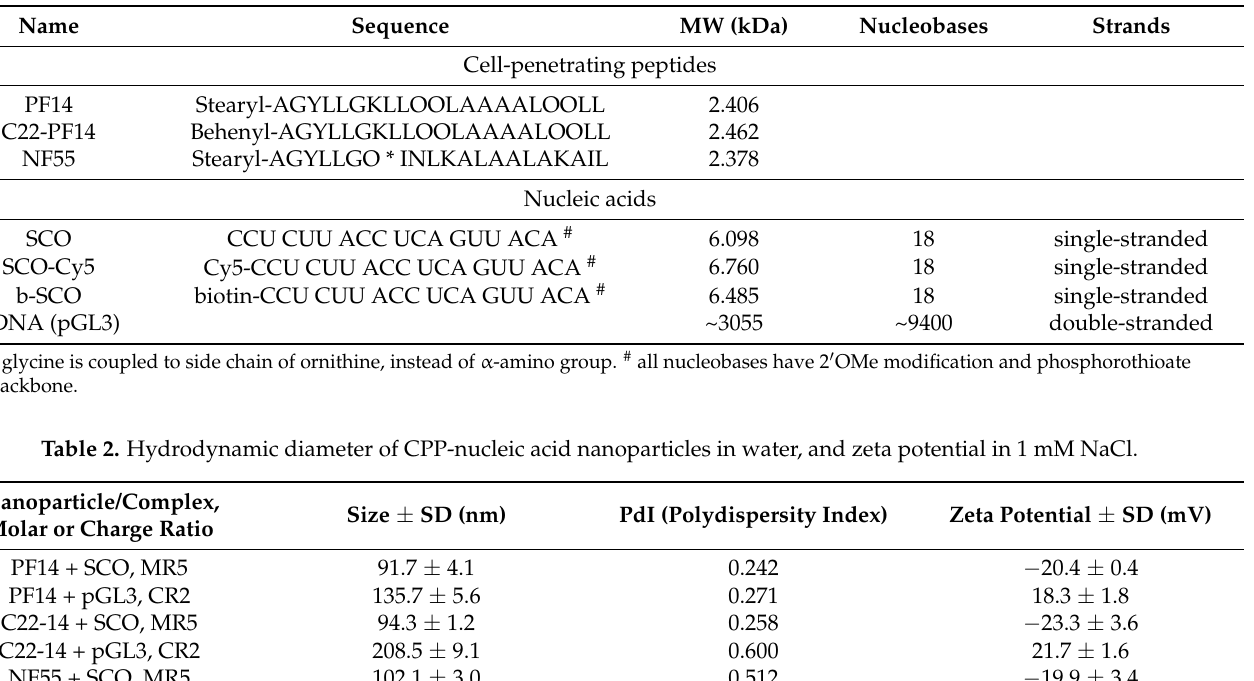
Table 1. Characteristics of cell-penetrating peptides (CPPs) and nucleic acids used in nanoparticles.